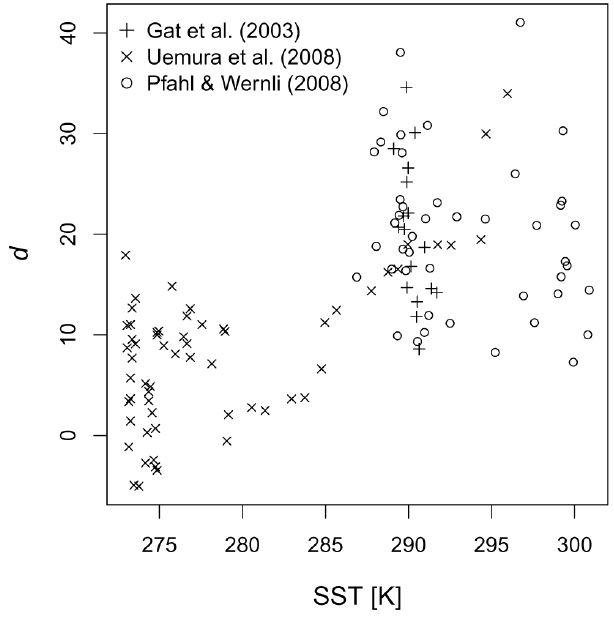
Fig. 5. Scatter plot of water vapour d from several published data sets (Gat et al., 2003; Uemura et al., 2008; Pfahl and Wernli, 2008) against SST at the oceanic moisture